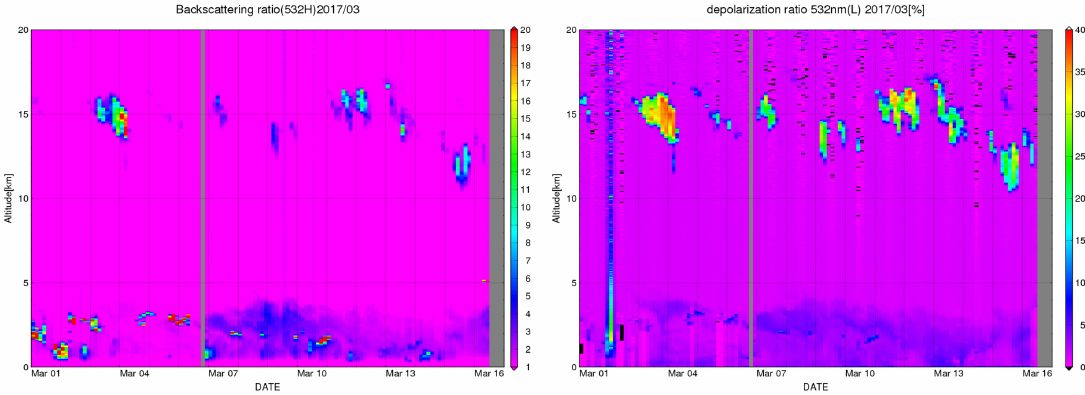
Figure 3. Time-Altitude transects of LiDAR backscatter and depolarization signals, dates are in local time (LT).